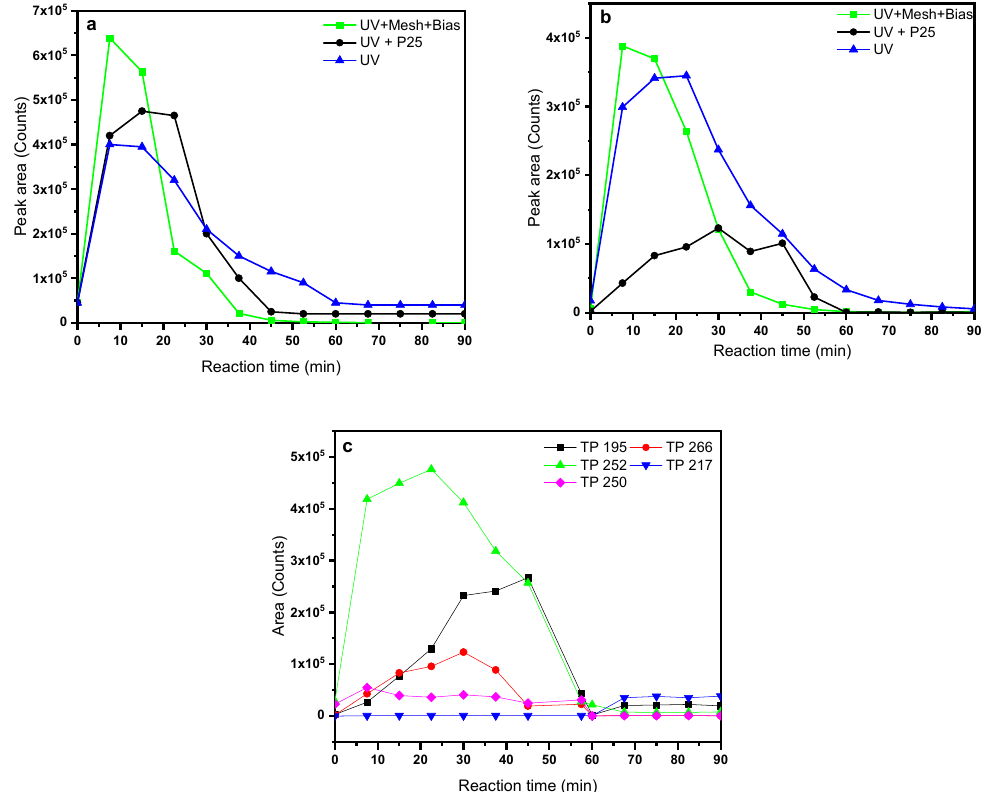
Figure A4. Time-profiles of the all the TPs at di ff erent reactor configuration: ( a ) Photo-electrocatalysis, ( b ) Photolysis, and ( c ) conventional photocatalysis with TiO 2 Degussa